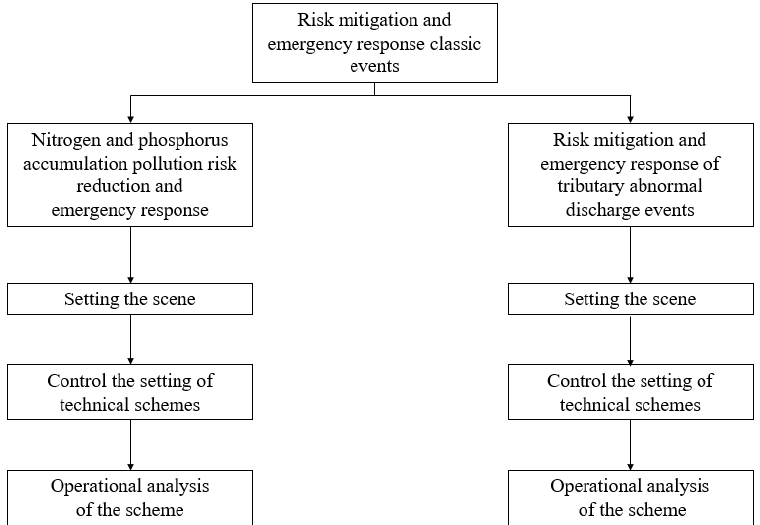
Figure 12. Risk mitigation and emergency response simulation flow chart.